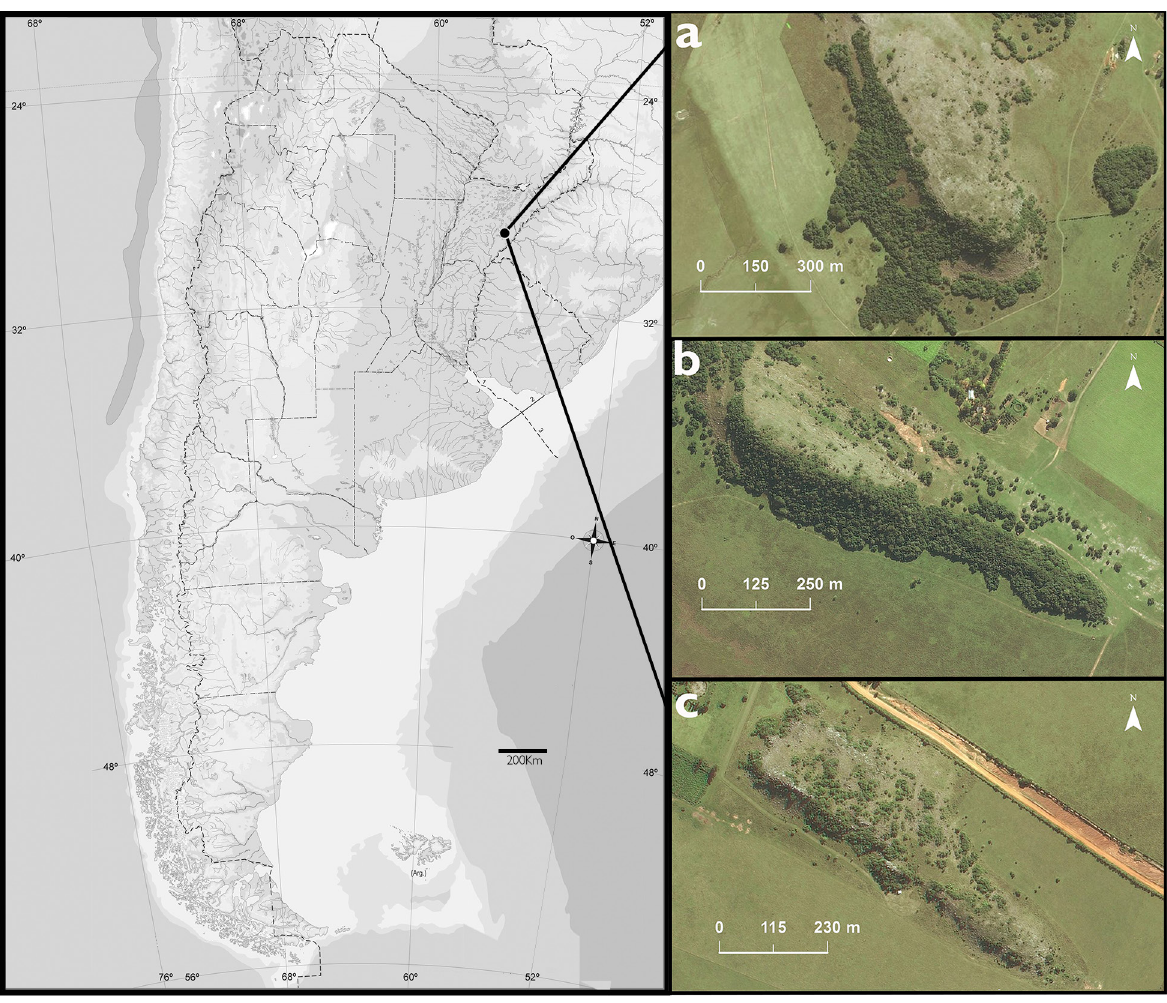
Figure 3. Distribution map of Homonota taragui . Location of the Paraje Tres Cerros, Corrientes province, Argentina. Details of the hills Nazareno (a), Capará (b), and Chico